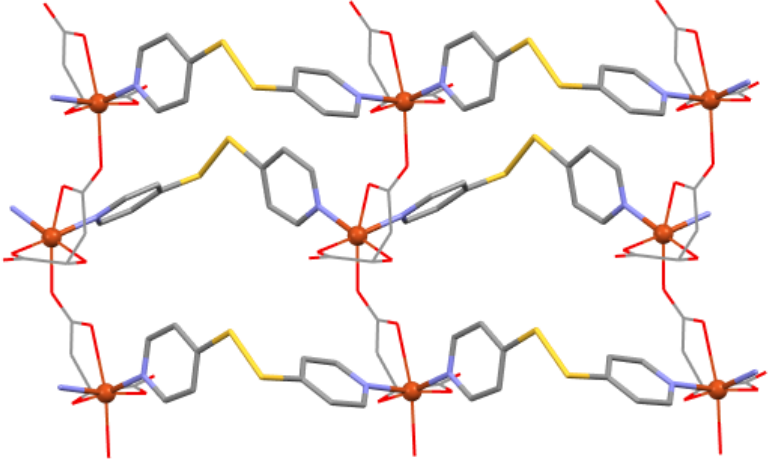
Figure 25. Coordination network in [Cu(malate)( μ - dtdp )·6H the right-handed P form of dtdp and the left-handed Cu( S -malate)